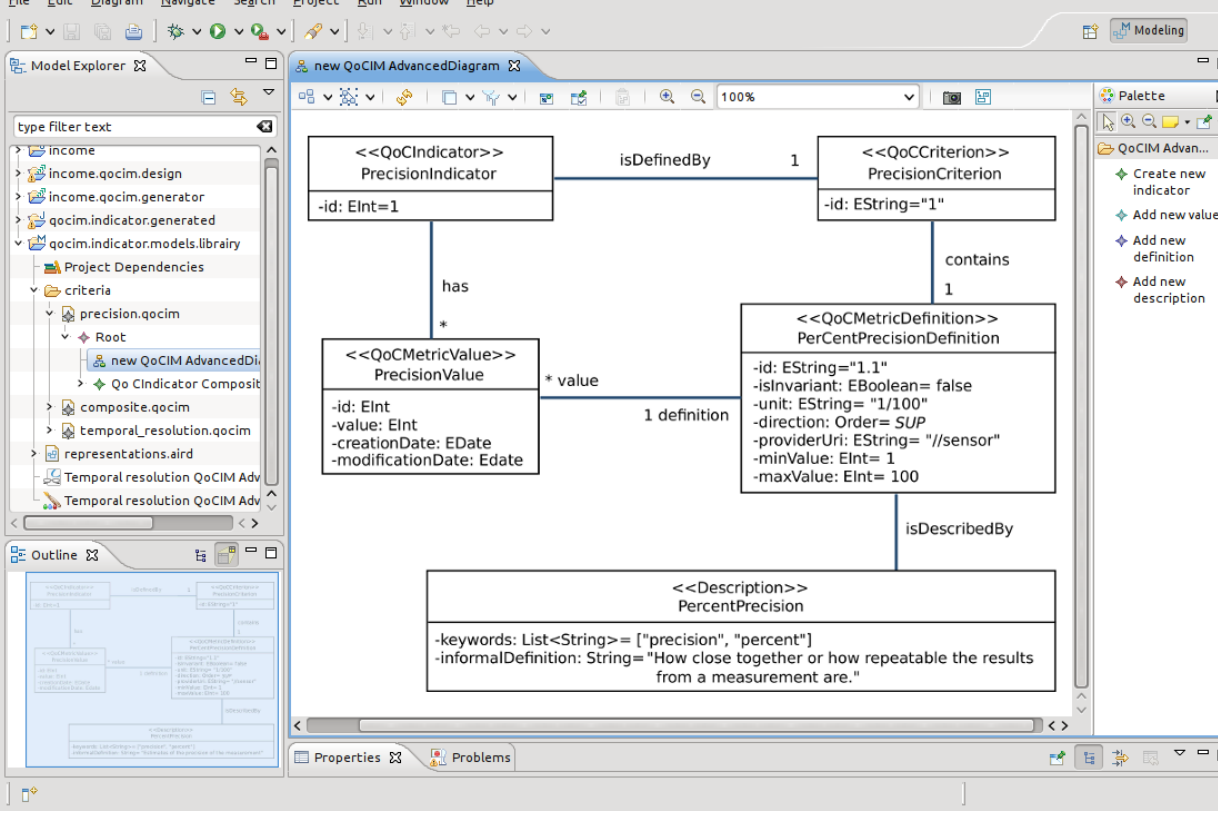
Figure 3. The QoCIM-based graphical